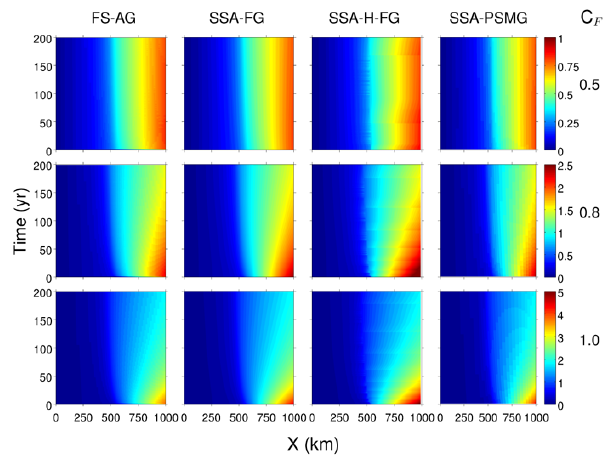
Fig. 3. Rate of surface elevation change (myr − 1 ) as a function of time and horizontal distance ( x = 0 corresponds to the ice divide and x f = 1000km is the calving front) for the three buttressing val- ues (lines) and for the four models (columns).